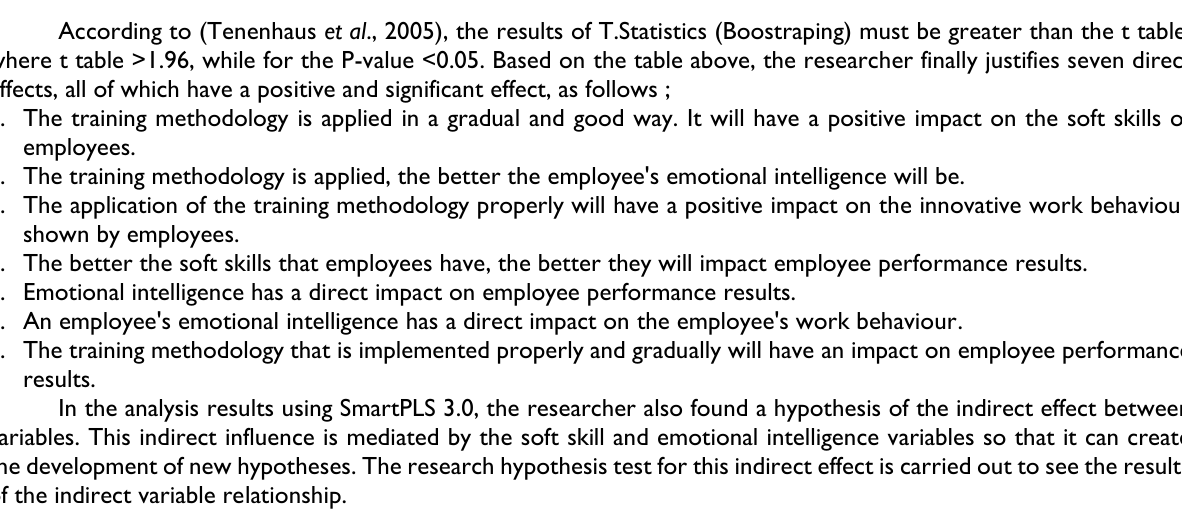
Table 5. Research Hypothesis Test Results for Indirect